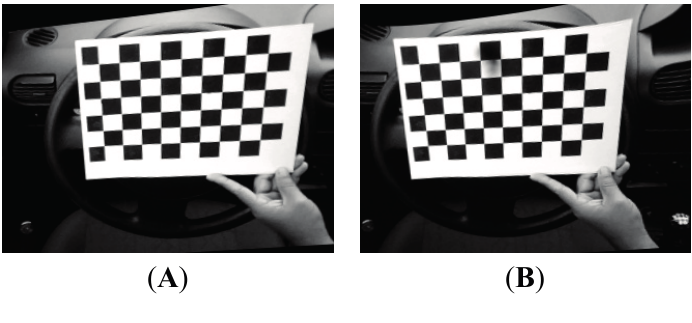
Figure 5. Camera calibration. ( A ) ChessboardL ( B ) ChessboardR ( C ) Rectified and remapped left ( D ) Rectified and remapped